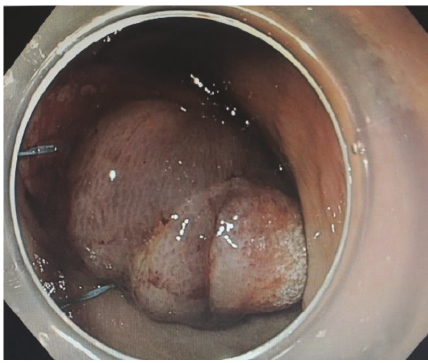
Figure 3: Endoscopic image of the mass after deployment of two gastric endoloops at the base.